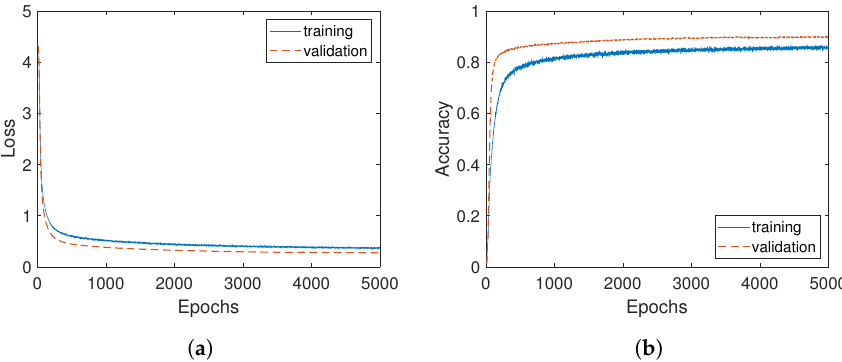
Figure 7. Learning metrics: loss ( a ) and accuracy ( b ) for training and